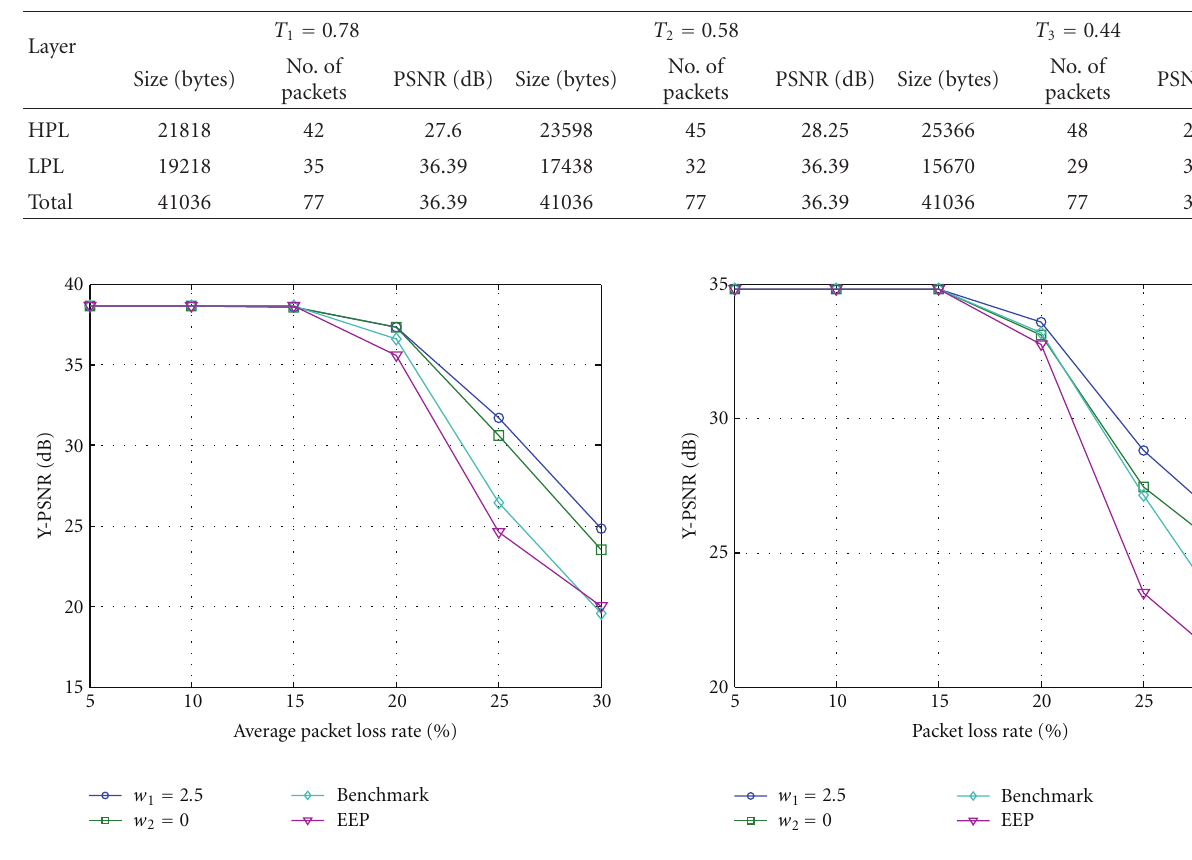
Table 2: Layer sizes and PSNR contributions for configurations with di ff erent values of T .